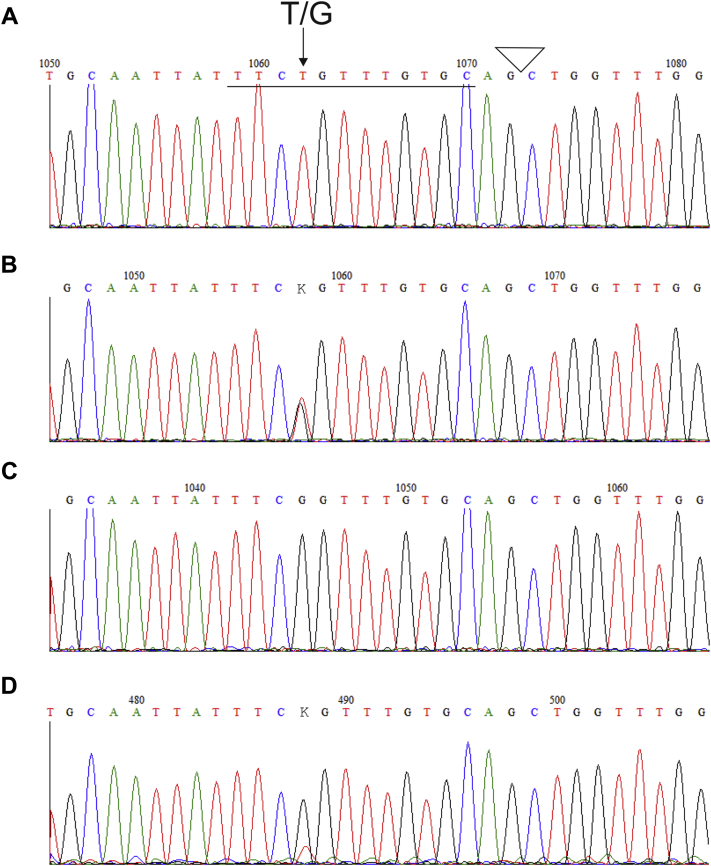
The heterogeneous pool of CRISPR-gRNA–transfected cells shows high levels of gene editing at the CYBB locus. Different ratios of WT and mutant plasmids were sequenced: (A) 100% WT, (B) 40:60 WT/mutant, and (C) 100% mutant. (D) This provided a standard curve of signal intensities at the T/G mutation site and allowed an estimate of the efficiency of gene conversion within a heterogeneous pool of gene-converted cells. The location of the G > T mutation is highlighted in (A), along with the polypyrimidine tract (underlined) and the splice site (inverted triangle). WT = wild type.